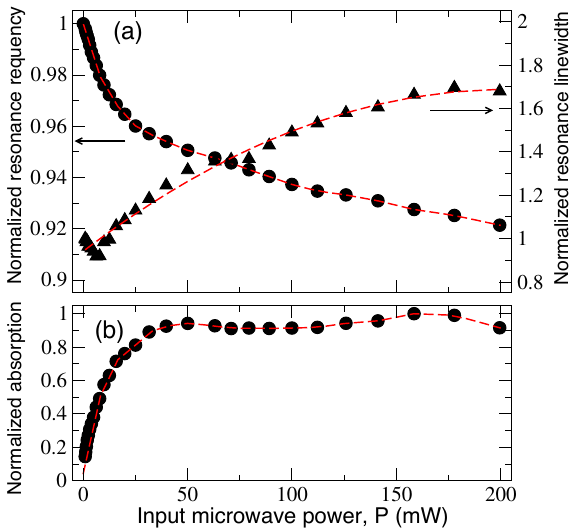
Figure 4. Experimental microwave power dependence for the fundamental Bloch DW resonance. (a) Reduced DW resonance frequency and reduced DW resonance linewidth as a function of the input microwave power P. The resonance frequency and the resonance linewidth are normalized by those in the linear regime ( P = 10 − 1 mW). (b) Reduced microwave power absorption at res- onance as a function of P. The amplitude of the microwave power absorption is normalized by its maximum value. The dashed lines are guides to the